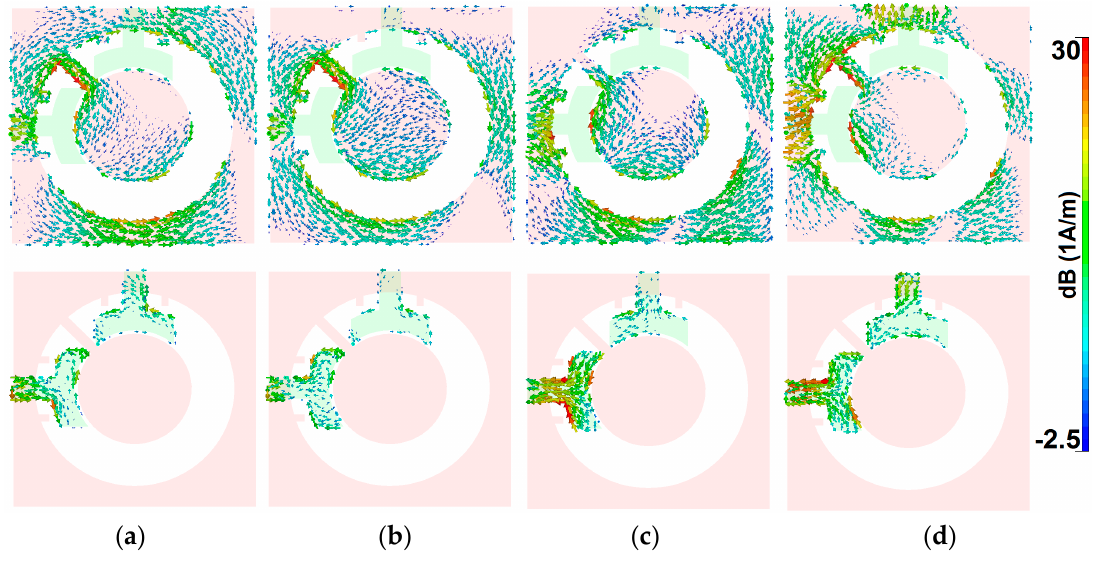
Figure 4. Current densities from Port 1 at resonances: ( a ) 3.8, ( b ) 4.2, ( c ) 7.1, and ( d ) 9.1 GHz.